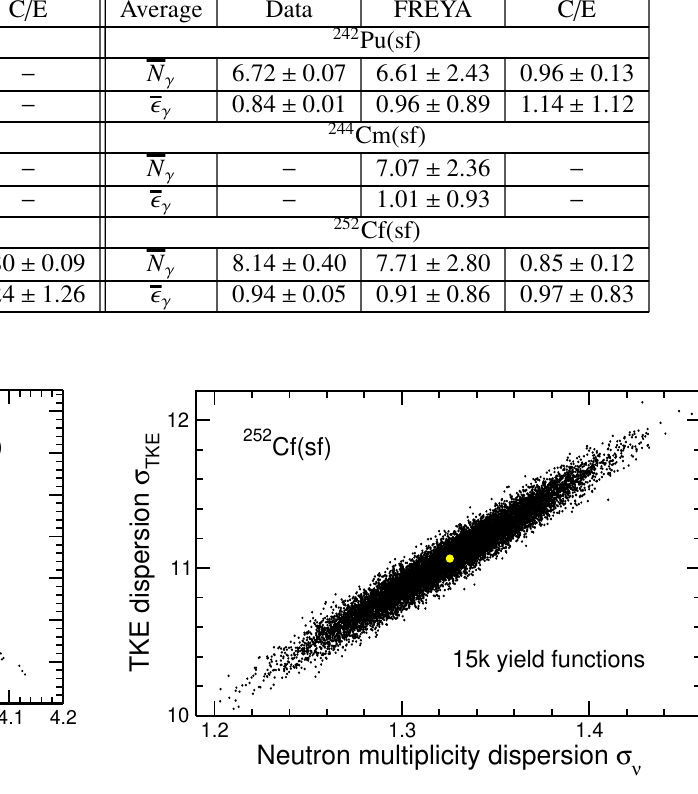
Figure 1. Scatter plot of the ν and TKE, obtained for each of the 15,000 sampled yield functions. The overall average is indicated by the central dot. (From Ref. [6].)